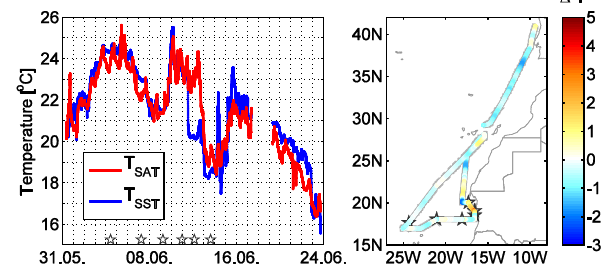
Fig. 3: Left: 10 minute average measurements of T SAT and T SST [°C]. The stars indicate 673 Fig. 3. Left: 10min average measurements of T SAT and T SST [ ◦ C]. position and time of the diurnal stations. Right: The temperature gradient is given in [K]. 674 The stars indicate position and time of the diurnal stations. Right: 675 the temperature gradient is given in [K].